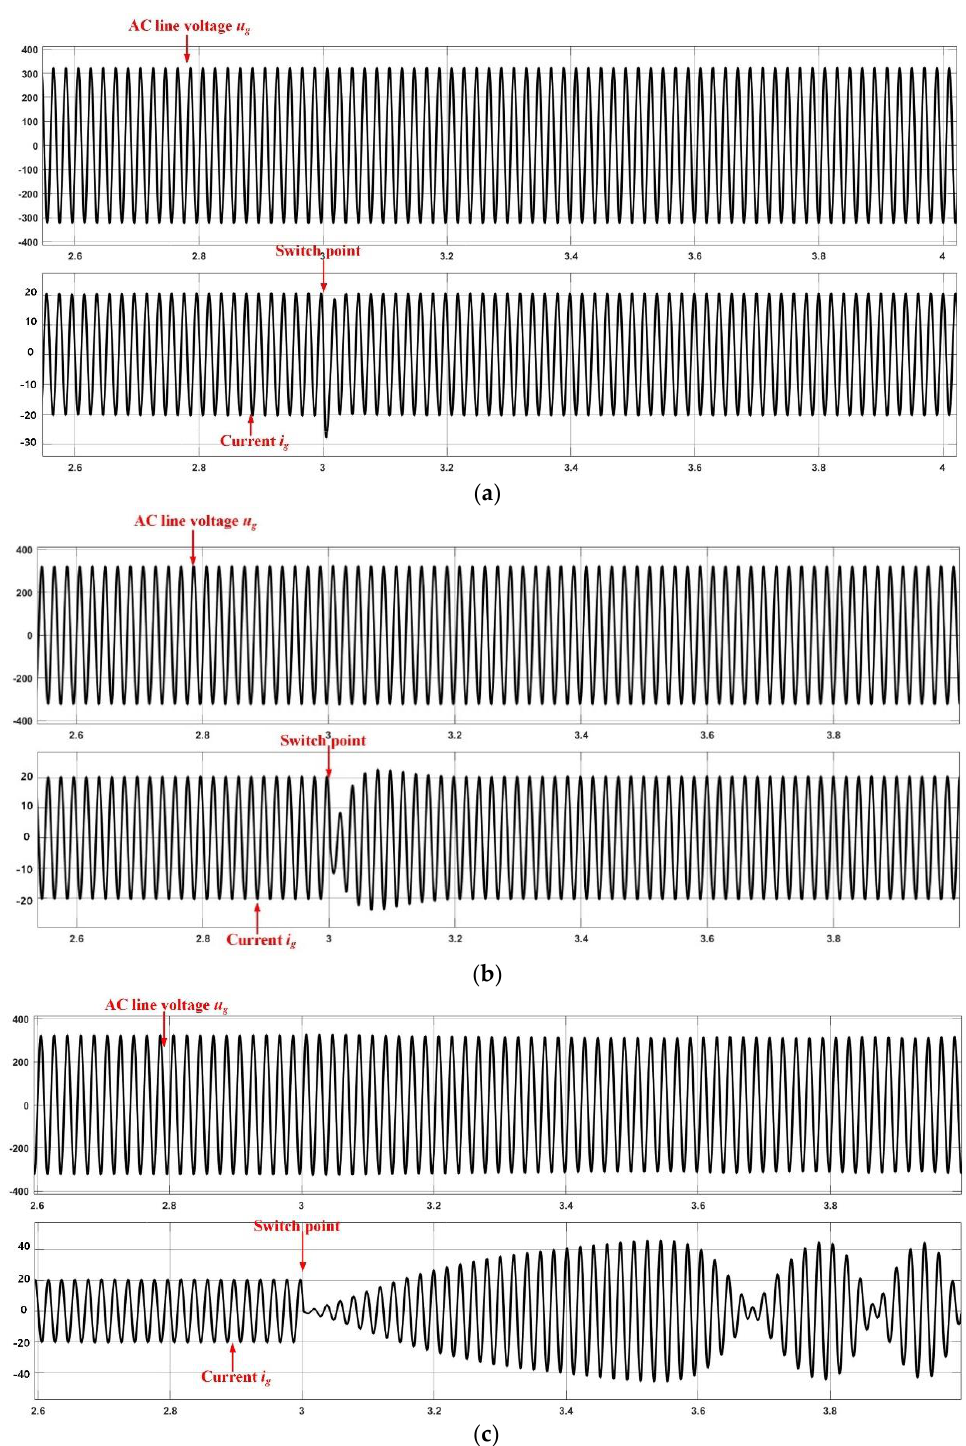
Figure 21. Dynamics of AC line voltage, synchronverter current, and disturbance with varied D f in the proposed auxiliary correction loop : ( a ) responses with D f = 3.5; ( b ) responses with D f = 0.1; ( c ) responses with D f = −1 .5.